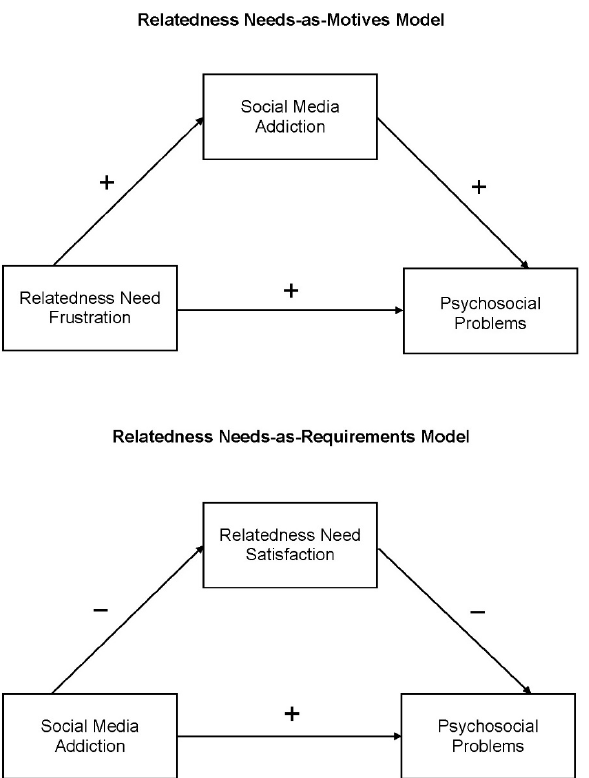
Figure 1. Conceptual frameworks of the relatedness needs-as-motives and the relatedness needs-as- requirements